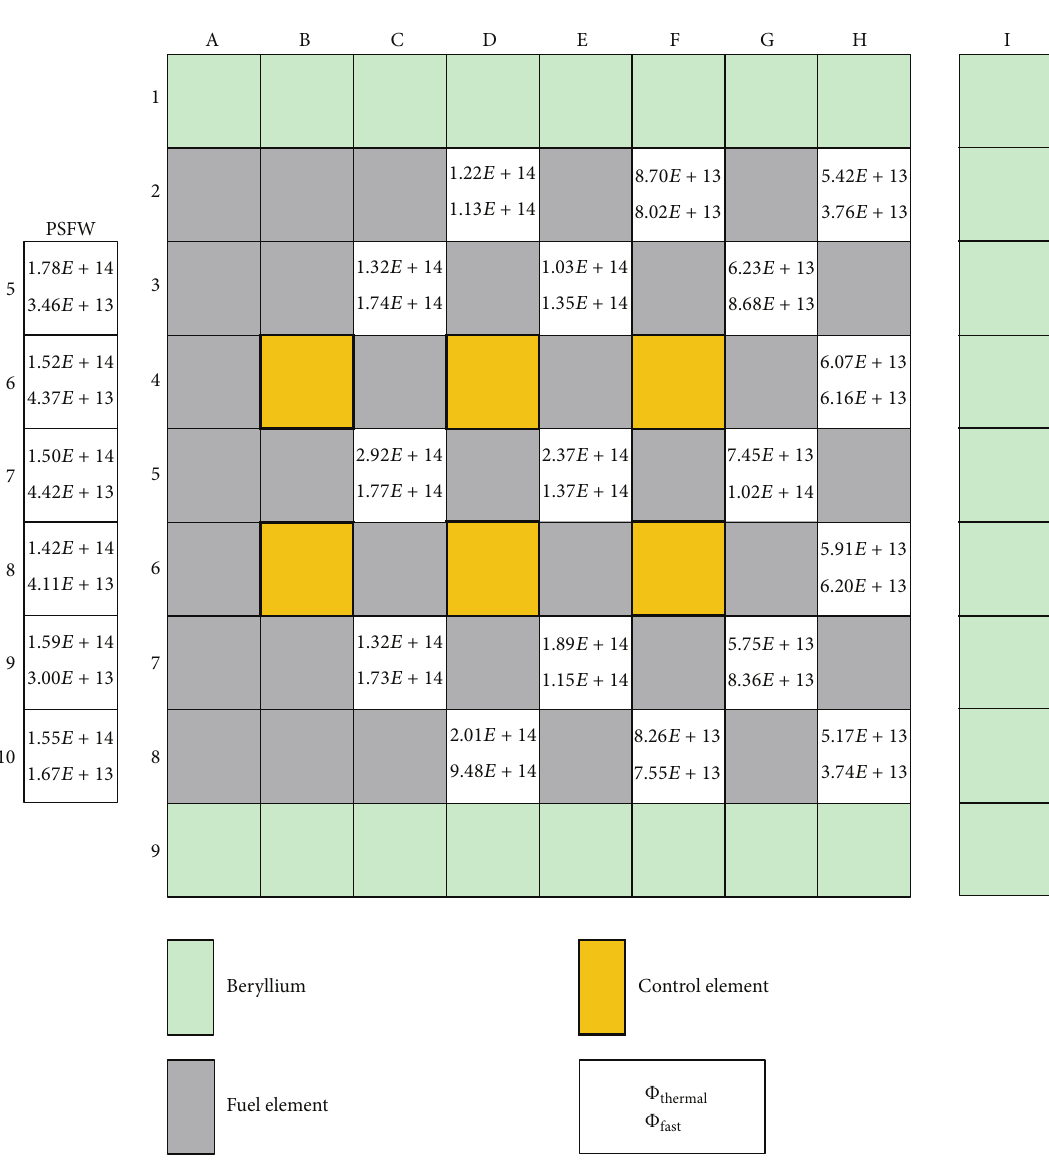
Figure 4: HFR cross-section